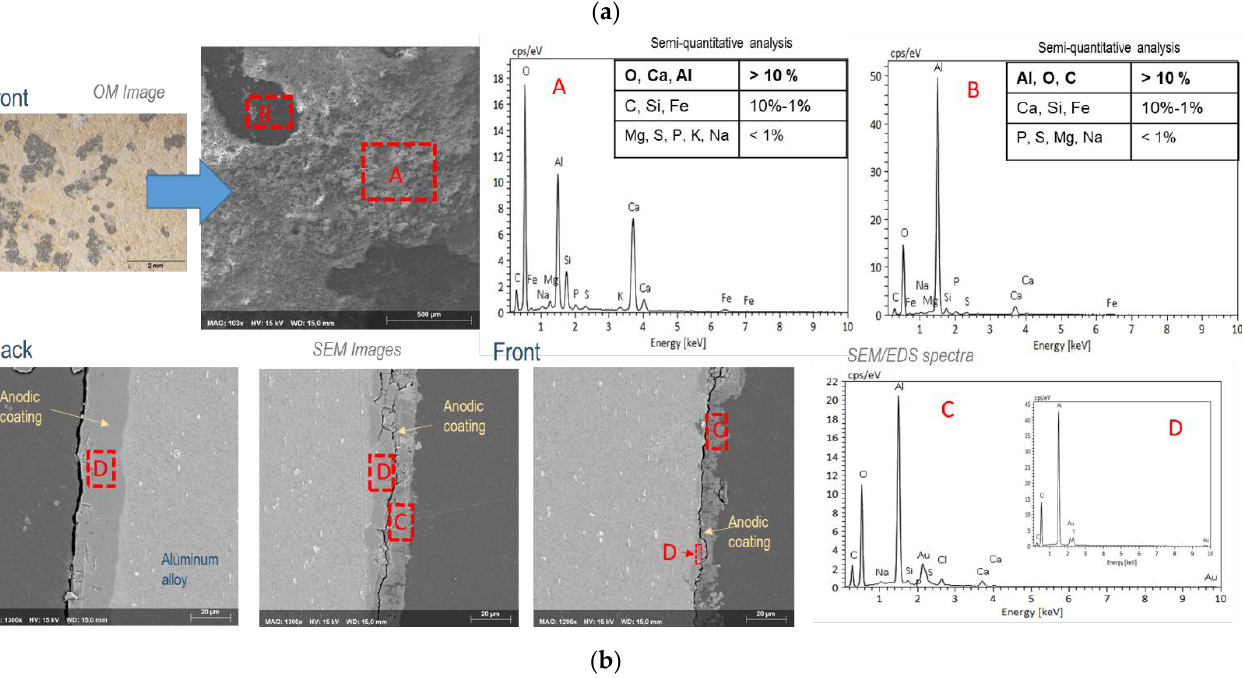
Figure 9. ( a ) Surface and ( b ) cross-sectional morphologies and analyses of the anodized aluminum test specimens exposed at the Rodão test site after 10 years ’ exposure. The OM and SEM images were obtained in zones with (front) and without (back) visible degradation of the anodic coatings; the EDS spectra and respective semi-quantitative analysis results shown are relative to the signaled zones in the SEM images.